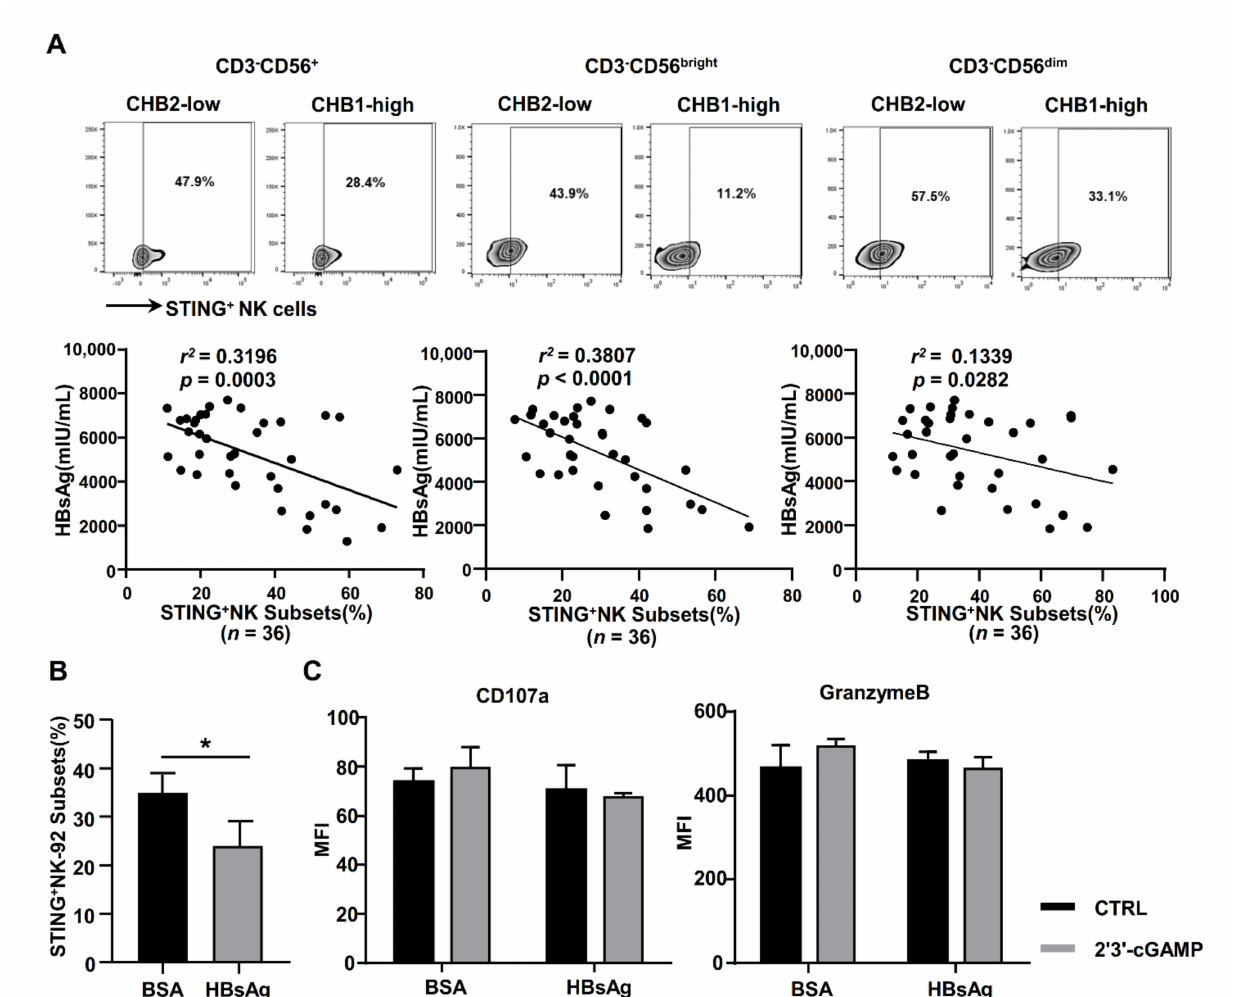
Figure 3. HBsAg inhibited the expression and response of STING in NK cells. ( A ) The correlation between serum HBsAg levels and STING expression levels in NK cells (CD3 - CD56 + , CD3 - CD56 bright and CD3 - CD56 dim cells) of CHB patients. ( B ) STING expression of NK-92 cells was analyzed by flow cytometry after incubation with HBsAg (20 µ g/mL) for 48 h. ( C ) The CD107a and Granzyme B levels of NK-92 cells incubated with HBsAg were analyzed by FACS after stimulation with 2 (cid:48) 3 (cid:48) -cGAMP (10 µ g/mL) for 6 h. Data are shown as mean ± SEM from three independent experiments. The statistically significant difference between two groups was determined by t -test. The correlation between variables was analyzed by the Pearson coefficient. * p < 0.05. 0.04 < r 2 < 0.16, weak correlationship; 0.16 < r 2 < 0.36, moderate correlationship; 0.36 < r 2 < 0.64, strong correlationship; CHB, CHB patients; NK, natural